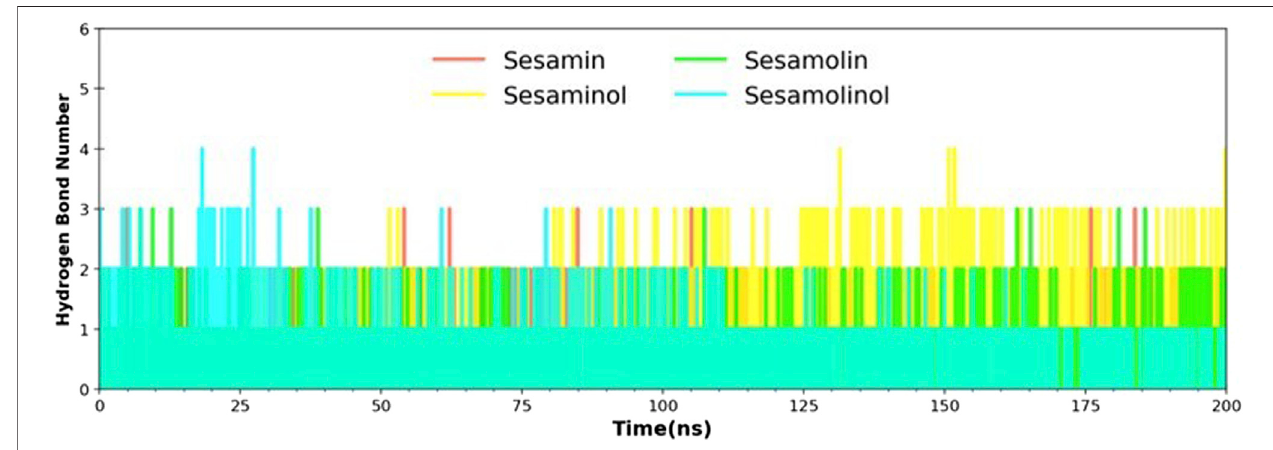
FIGURE 6 | Hydrogen bond analysis of docking complexes [M pro – sesamin complex (red), M pro – sesamolin complex (green), M pro – sesaminol complex (yellow), and M pro – sesamolinol complex (cyan)].